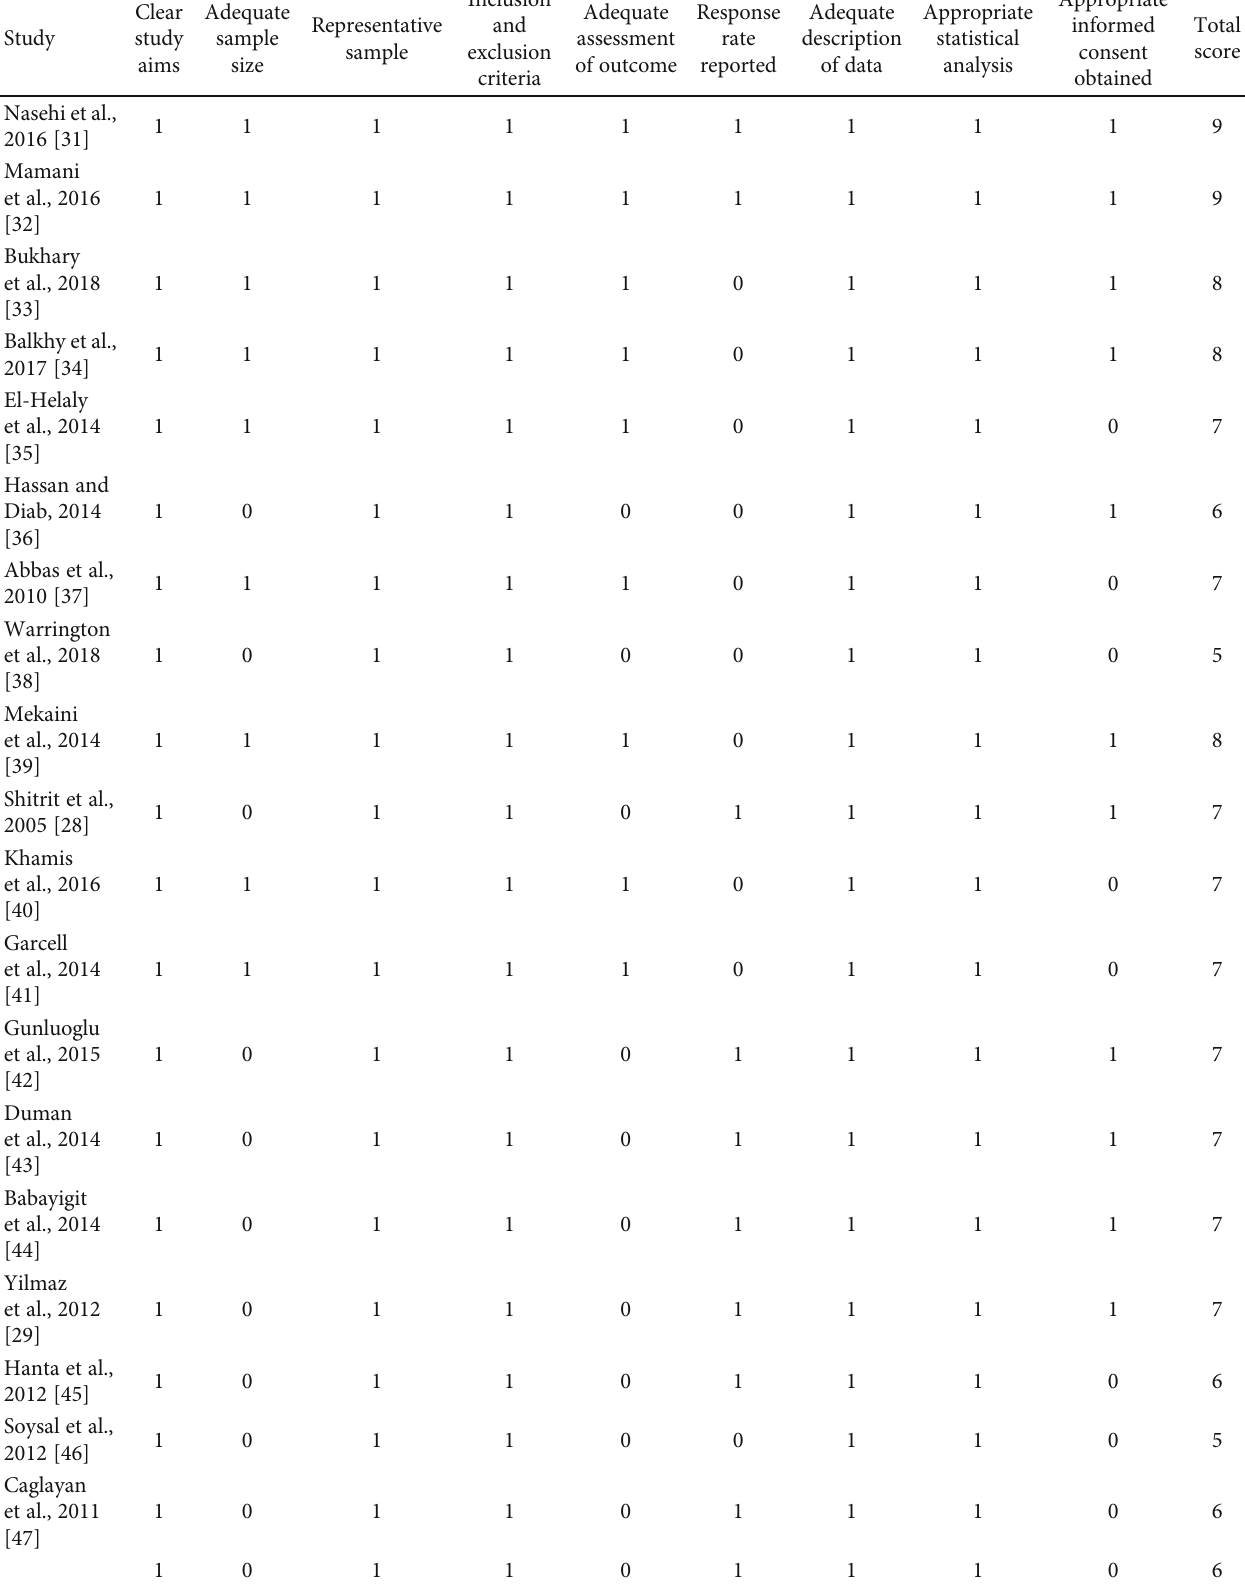
Table 2: Quality assessment of the studies included in the